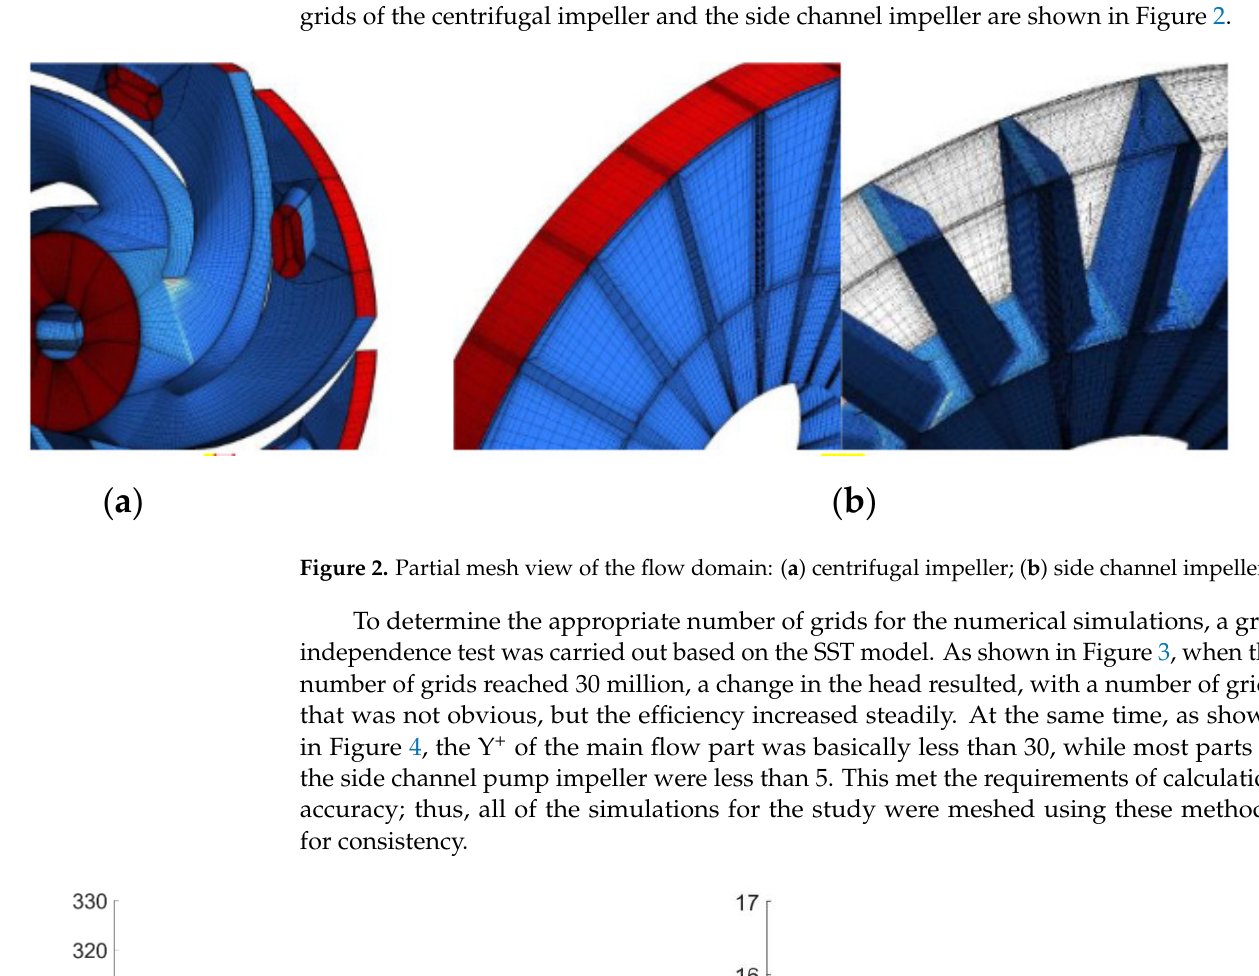
Figure 1. Water structure diagram of the investigated multistage side channel pump.